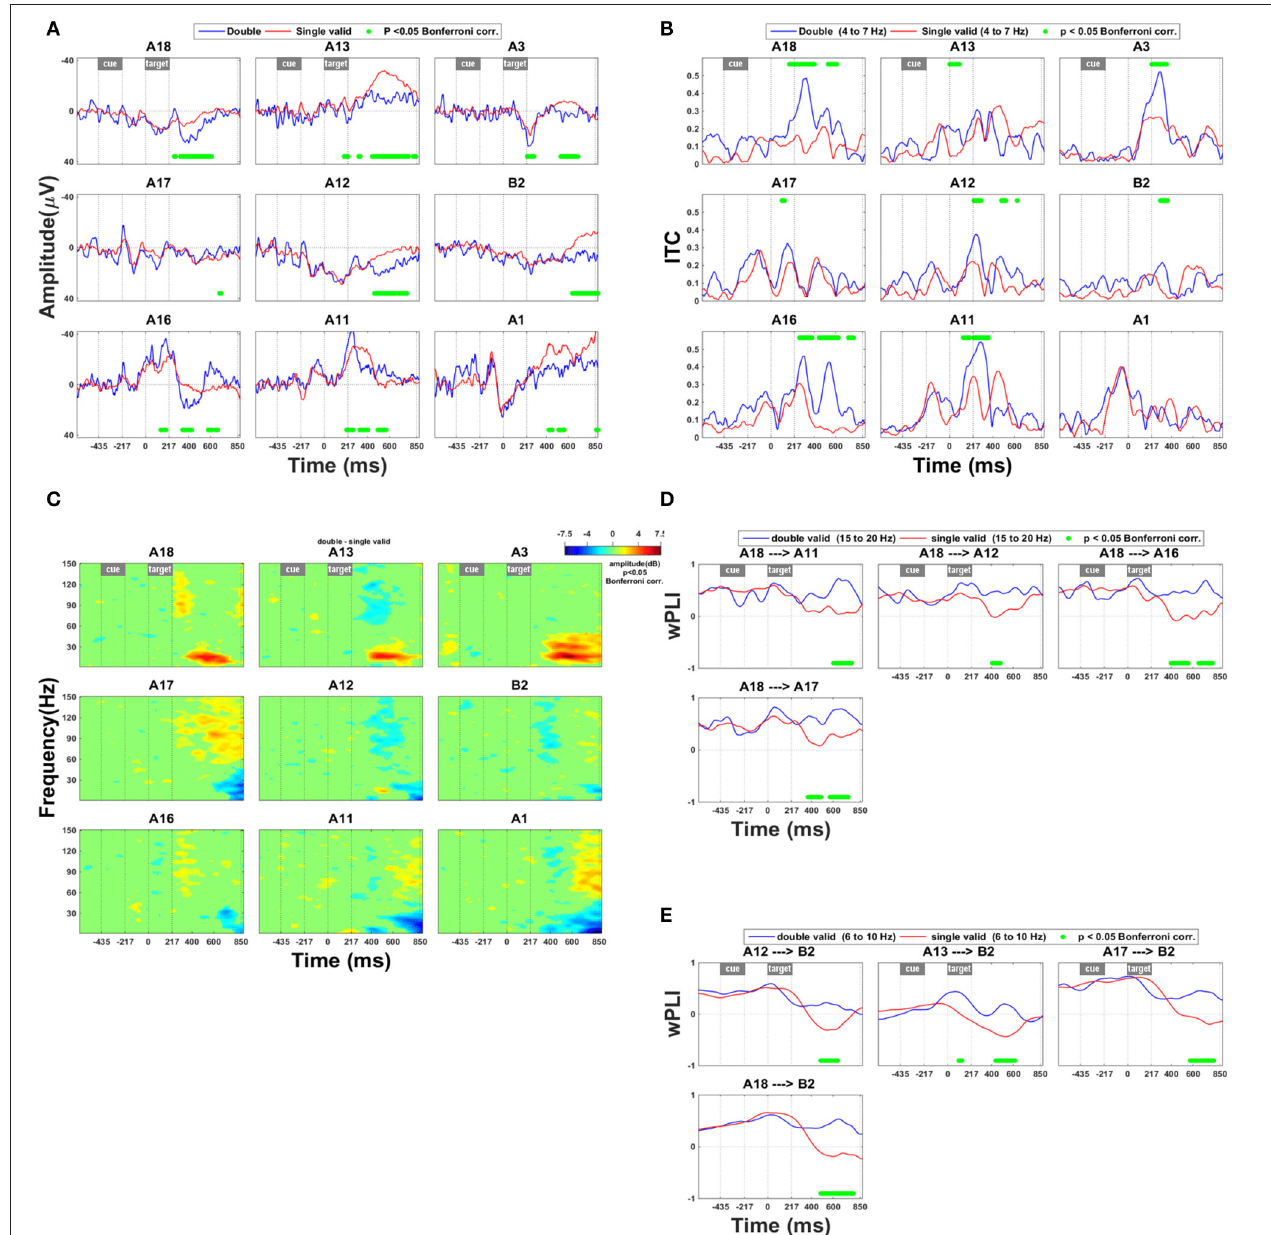
FIGURE 4 | Effect of the presence of a competing stimulus. (A) ERP during competition trials compared to validly cued single-grating trials. Significant deficits following target onset between validly cued and invalidly cued trials are marked by a green bar. The significance threshold is set at P < 0.05 corrected for the number of electrodes during a minimum continuous period of 10 ms. The plots for the different electrodes are placed in accordance with their position on the cortical surface ( Figure 1A ). (B) Inter-trial coherence during competition trials compared to validly cued single-grating trials. The significance threshold is set at P < 0.05 corrected for the number of electrodes ( n = 9) using a nonparametric bootstrapping approach with 1,000 randomizations. (C) Time-frequency plots during competition trials minus validly cued single-grating trials. The ERSP was thresholded at P < 0.05 corrected for the number of electrodes ( n = 9) using a nonparametric bootstrapping approach with 1,000 randomizations. (D) wPLI analysis indicating the effect of competition trials compared to valid single-grating trials on functional connection between anterior and posterior IPS in the frequency band 15–20 Hz. The significance threshold was P < 0.05 corrected for the number of connections tested ( n = 36) using a nonparametric bootstrapping approach with 2,000 randomizations. (E) wPLI analysis indicating the effect of competition trials compared to valid single-grating trials on the functional connection between IPS and SPL in the frequency band 6–10 Hz. Same significance threshold as in (D) .